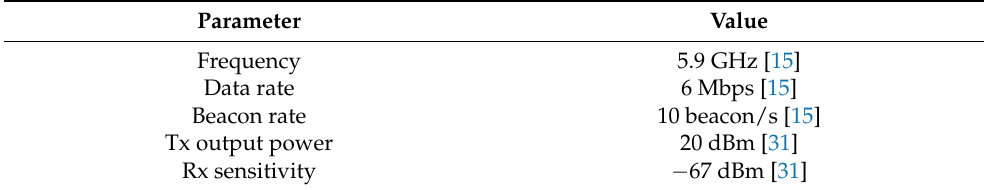
Table 2. Parameters for the communication